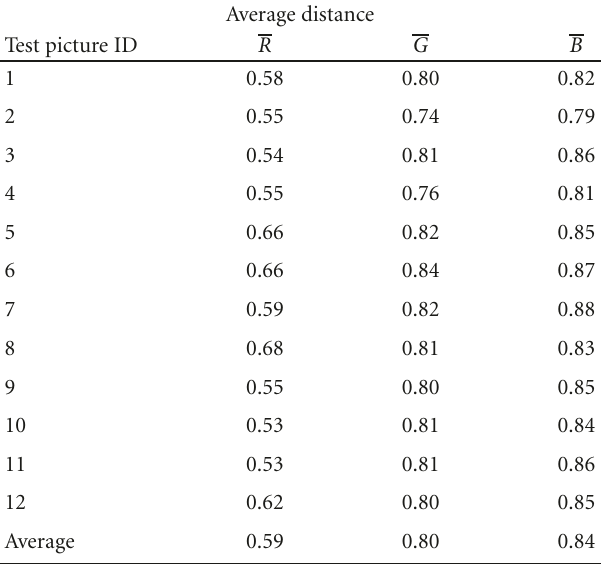
Table 1: The analysis of average distance. Average distance